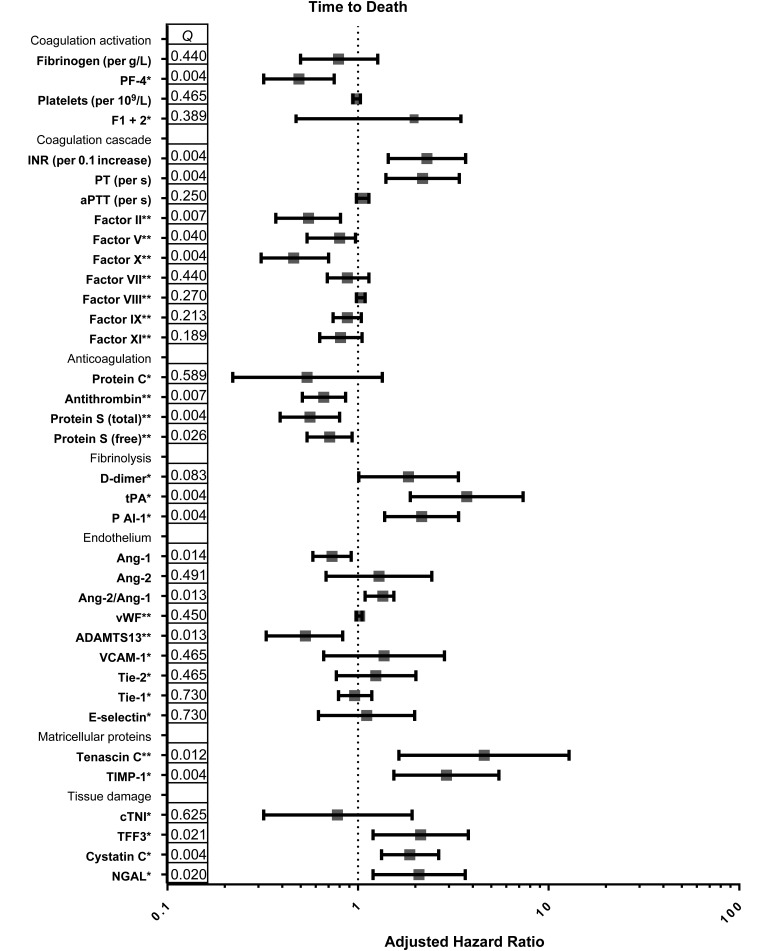
Hemostatic changes and time to death. Figure shows adjusted hazard ratios and 95% confidence intervals for respective variables, calculated with Cox proportional hazard analysis. A priori–defined potential confounders were age, sex, antiretroviral therapy status, human immunodeficiency virus (HIV) load and CD4 cell count. A potential confounder was retained in the final model if introduction of the confounder to the model lead to a >10% change of the effect measure. Q values (corrected P values) are shown per log2 pg/mL increase (*) or per 10% increase (**), depending on assay used. Abbreviations: ADAMTS-13, a disintegrin and metalloproteinase with a thrombospondin type 1 motif, member 13; Ang 1 and Ang 2, angiopoietin 1 and 2; aPTT, activated partial thromboplastin time; cTNI, cardiac troponin I; FI + II, factor I + II; INR, international normalized ratio; NGAL, neutrophil gelatinase-associated lipocalin; PAI-1, plasminogen activator inhibitor type I; PF-4, platelet factor 4; PT, prothrombin time; TFF3, trefoil factor 3; Tie-1 and Tie-2 tyrosine kinase with immunoglobulinlike and epidermal growth factor–like domains 1 and 2; TIMP-1, metallopeptidase inhibitor 1; tPA, tissue plasminogen activator; VCAM-1, vascular cell adhesion protein 1; vWF, von Willebrand factor.